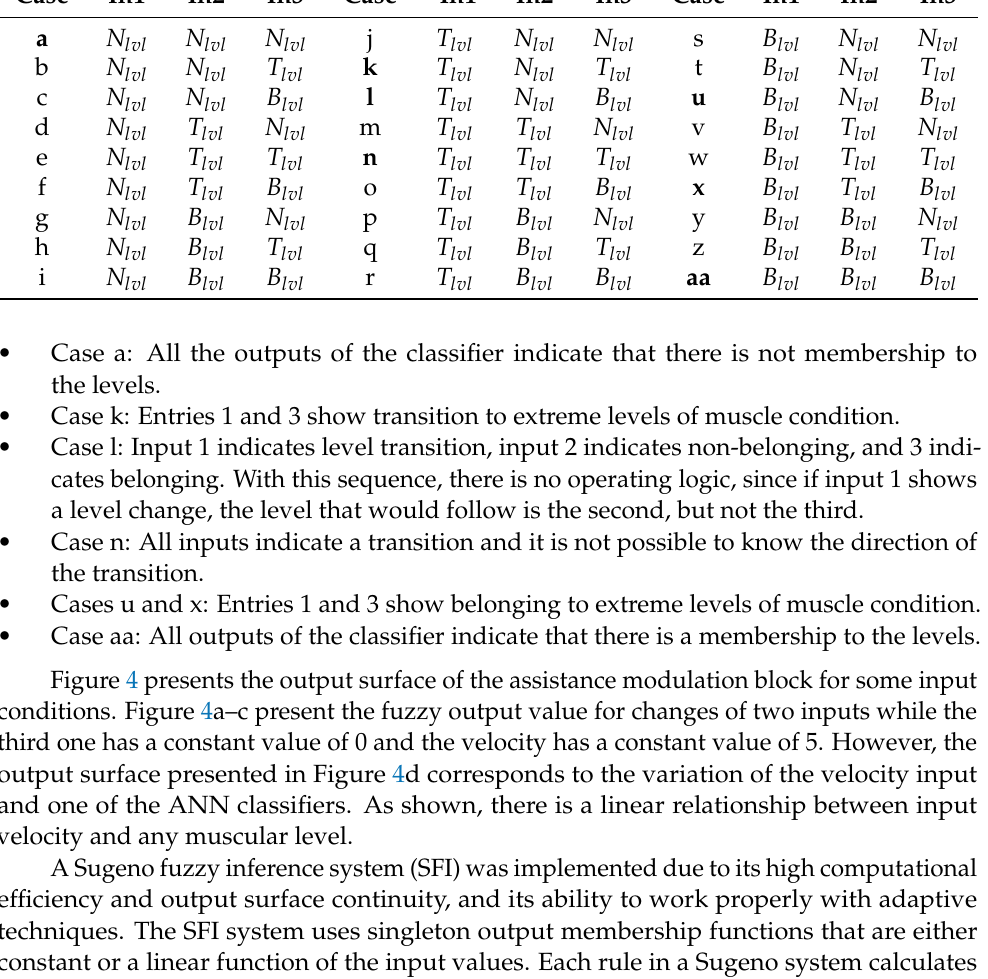
Table 2. Combination of the inputs (ANN classifier outputs) for three states: not belonging to the corresponding muscular condition level ( N lvl ), transition between muscular levels ( T lvl ), and belonging to the corresponding muscular condition level ( B lvl ).